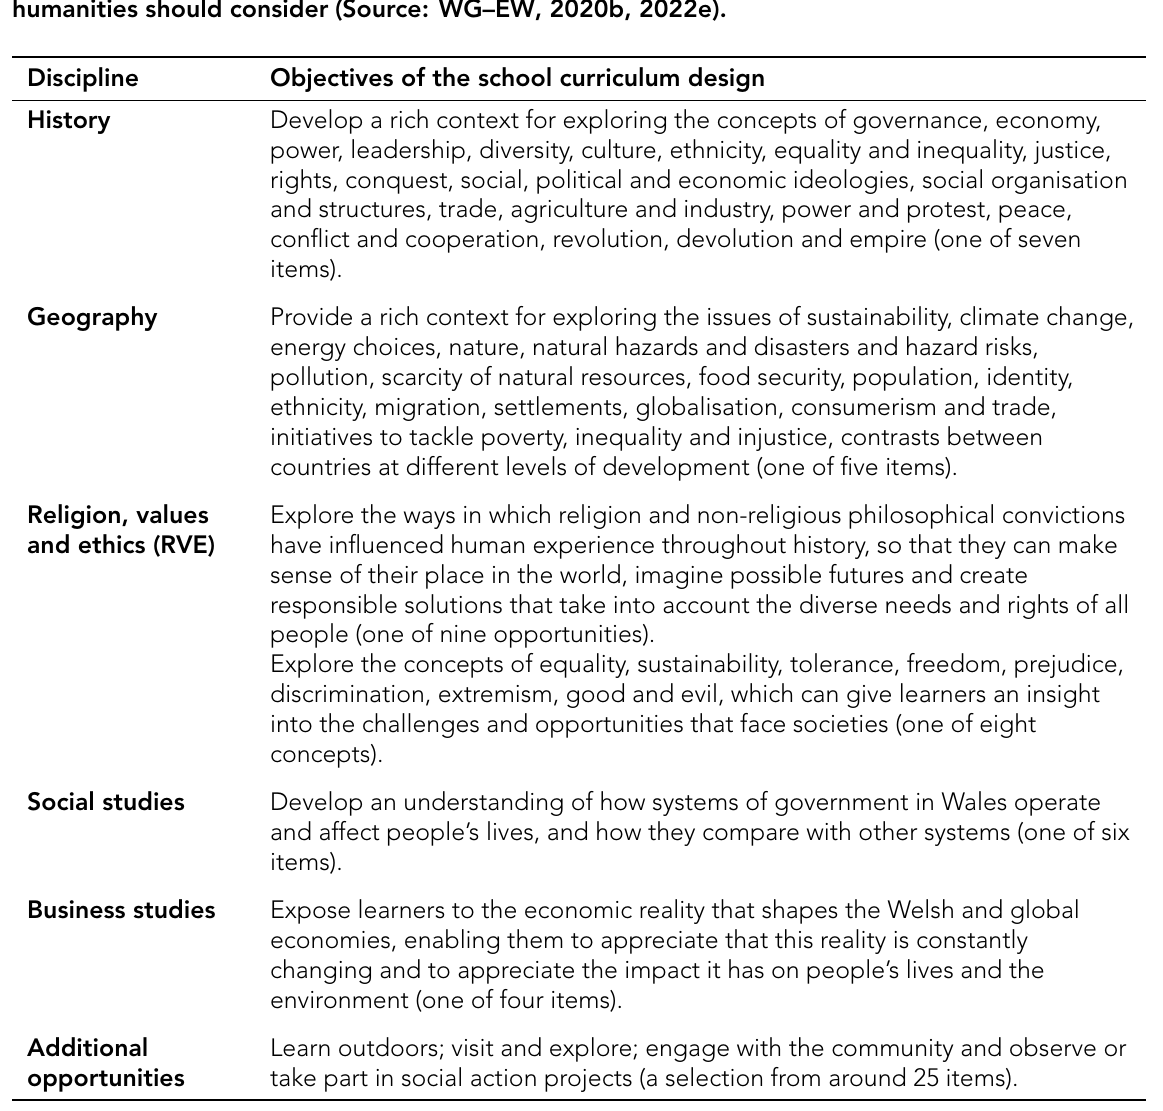
Table 1. A selection from the disciplinary concepts and contexts that curriculum design in the humanities should consider (Source: WG–EW, 2020b,